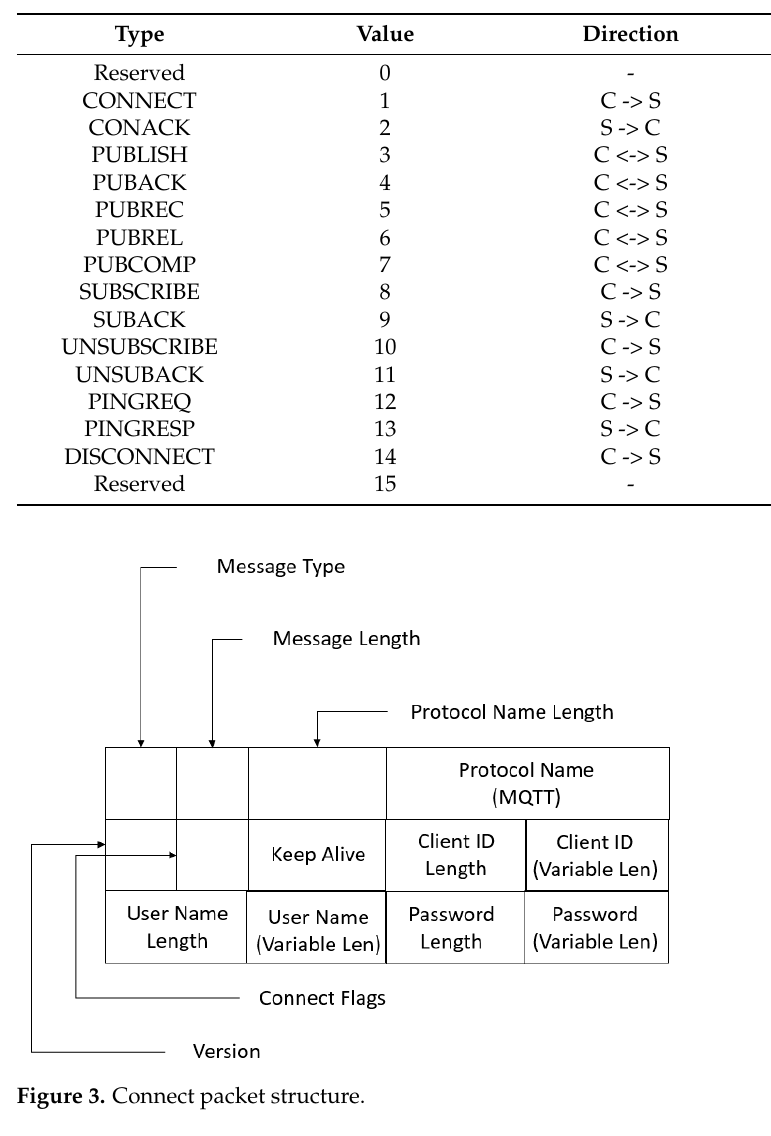
Figure 5. Subscribe request packet structure. Fourth, a publish packet is provided. The structure of a publish packet is shown in Figure 6, and it includes a message, message type, and topic. Figure 6. Publish packet structure. 4. MQTT Attack Analysis Various attacks, such as DoS, flood, SlowITe, malformed, and brute-force attacks, can attack the MQTT protocol [6]. This section analyzes these attacks to extract features that can be used to identify malicious MQTT traffic.